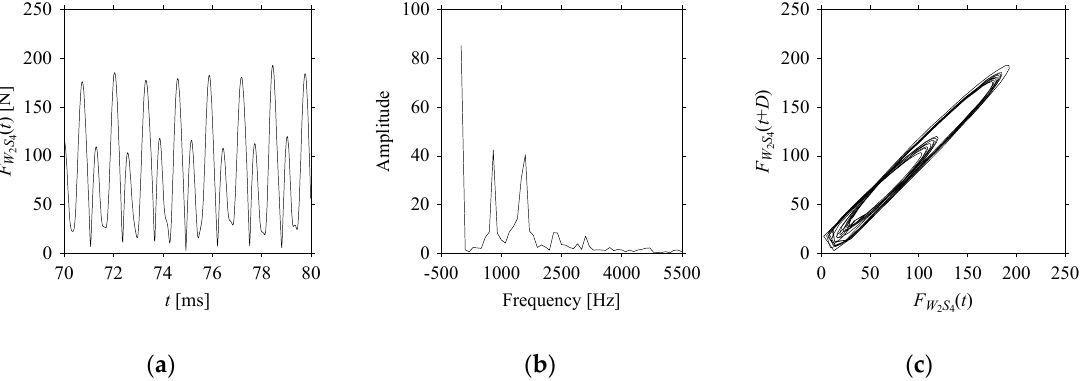
Figure A7. F W in the form of: ( a ) time series, ( b ) fast Fourier Transformation (FFT), and ( c ) delay map ( d = 1). 2 S 4